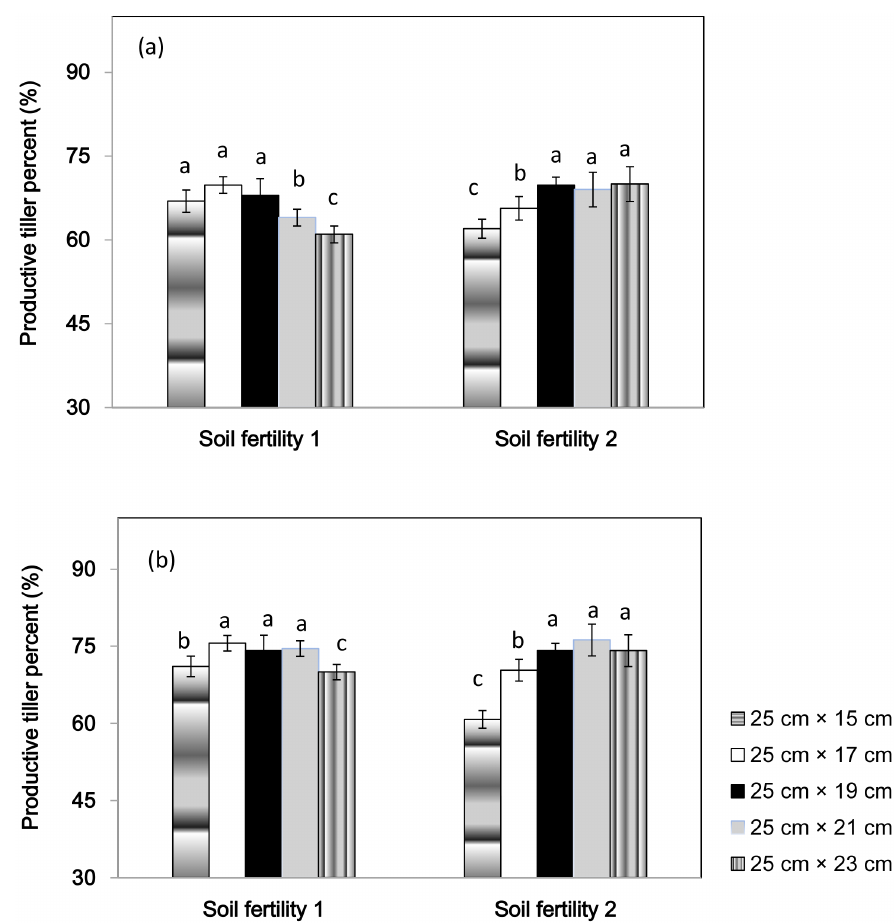
Figure 2. Productive tiller percentage of a high-yielding hybrid rice variety Nei2you6 grown at five seeding spacings in soil fertility 1 and soil fertility 2. China National Rice Research Institute, Zhejiang Province, China, 2010 (a) and 2011